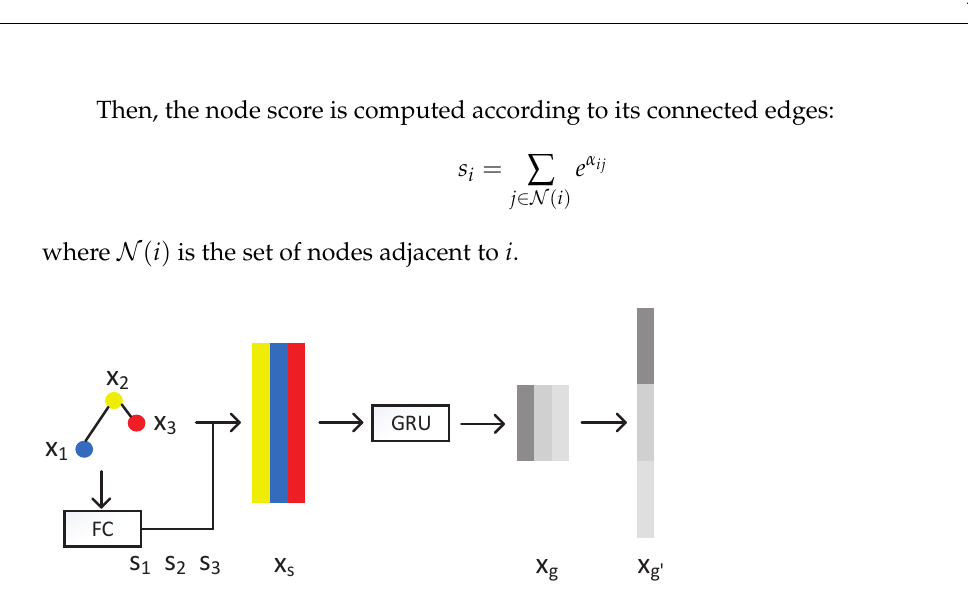
Figure 3. The Global Structure Attention Pooling (GSAP) process. Qualitatively, we assume that the graph has three